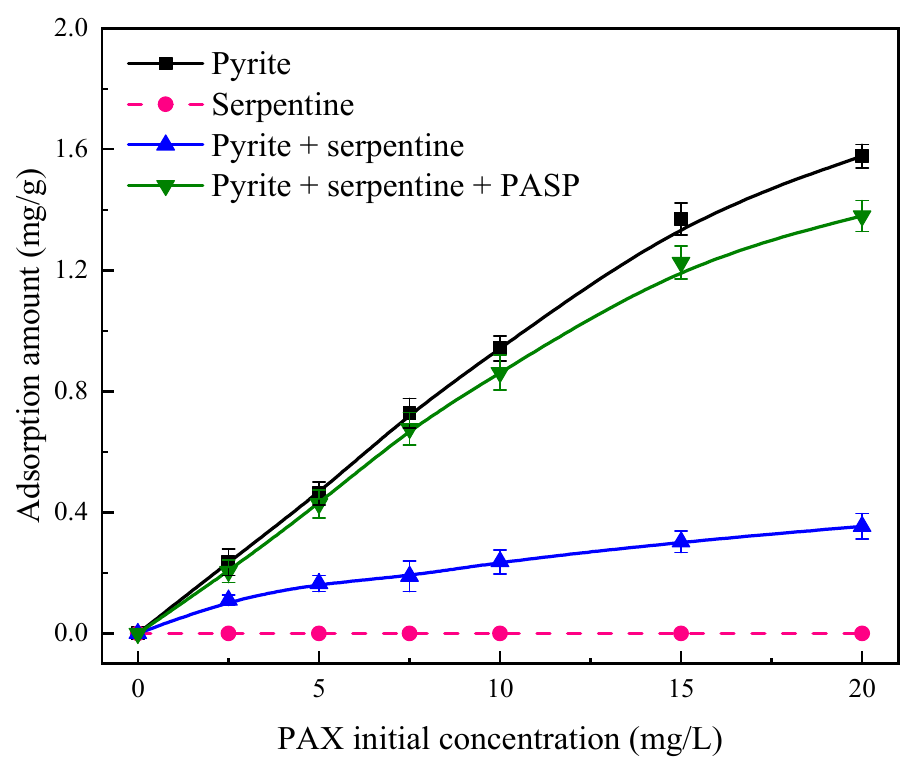
Figure 10. Adsorption amounts of PAX on the pyrite surface and serpentine ( − 10 µ m) under different conditions (pH = 9, [PASP] = 15 mg/L).